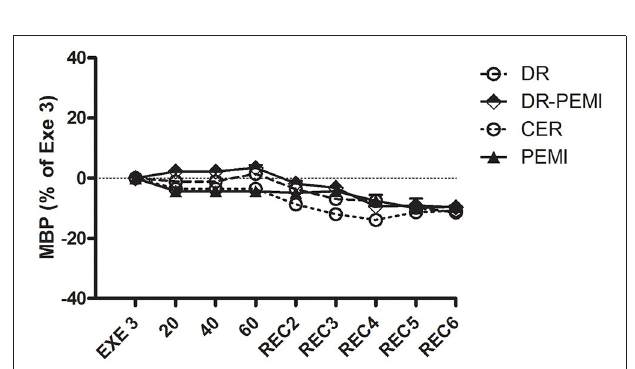
FIGURE 6 | MBP time courses during all four tests. Values are means ± SD percentages of the end of handgrip (EXE3).